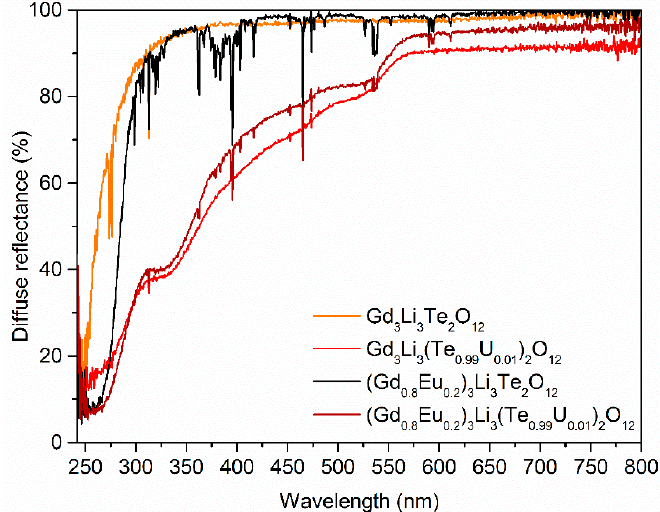
Figure 6. Diffuse reflectance spectra of Gd 3 Li 3 Te 2 O 12 (orange line), Gd 3 Li 3 (Te 0.99 U 0.01 ) 2 O 12 (red line), (Gd 0.8 Eu 0.2 ) 3 Li 3 Te 2 O 12 (black line), and (Gd 0.8 Eu 0.2 ) 3 Li 3 (Te 0.99 U 0.01 ) 2 O 12 (dark red line).